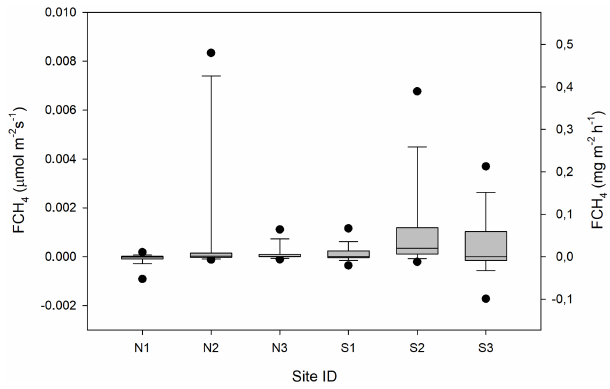
Figure 11. Temperature sensitivity for ecosystem respiration ( R eco ) (brown) and R g -normalized (positive) gross primary productivity (GPP) (green).